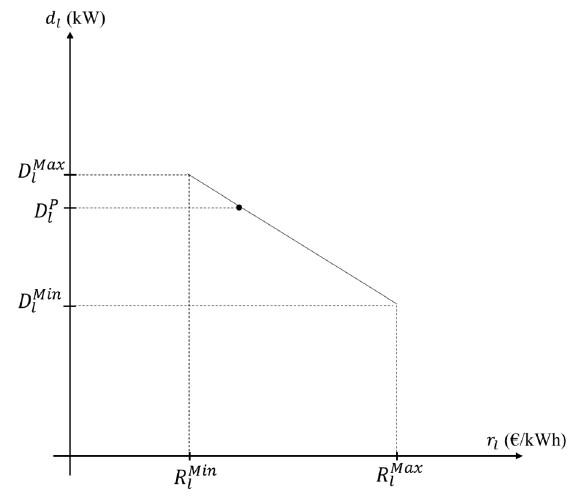
Figure 2. Typical demand function.